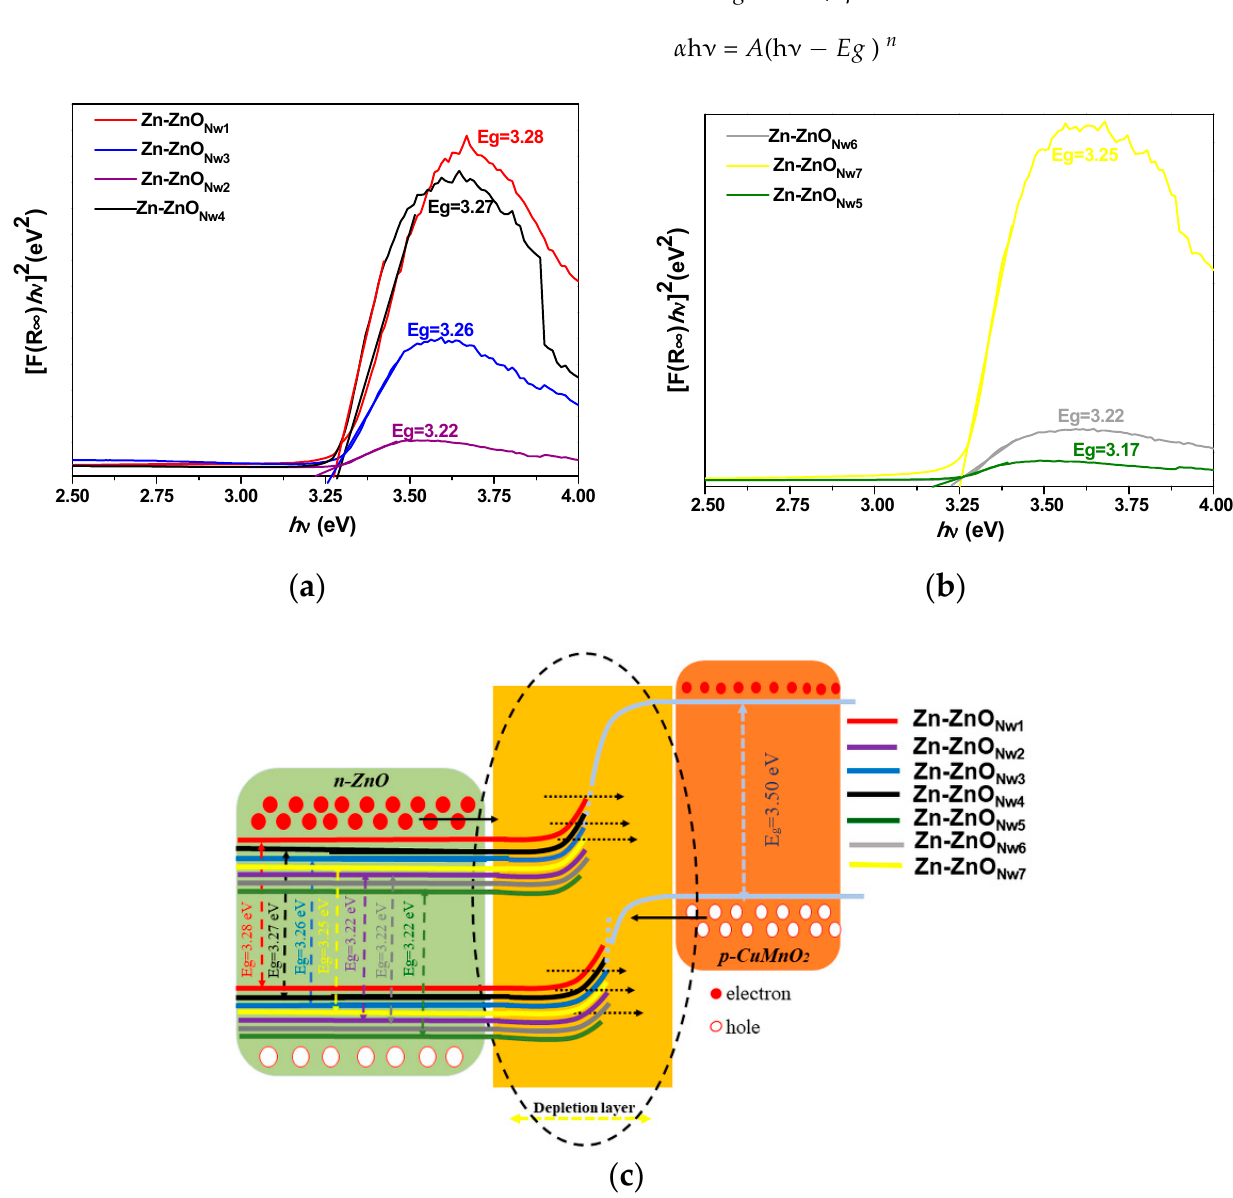
Figure 6. Band gap calculation Eg against energy ( eV ) for Zn-ZnO (NW) supports ( a , b ); Diagram for corresponding conduction and valence band edges ( c ). Figure 7a–f presents the I-V curves of the experimental sensor type on